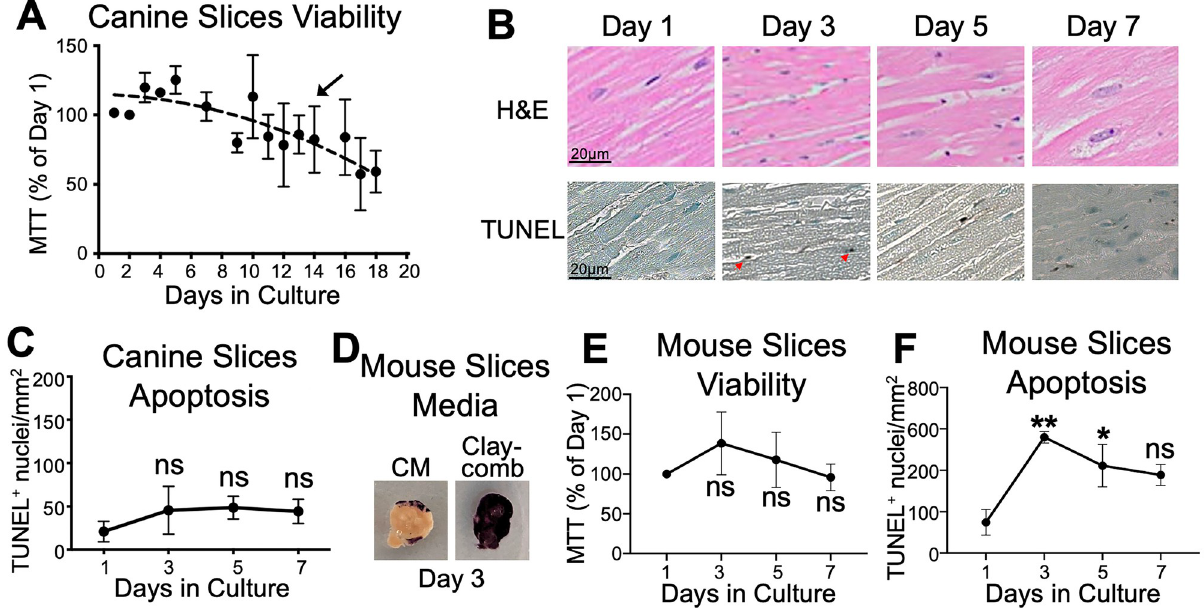
Fig 1. Canine cardiac slices are viable for > 7 days in culture. A. No significant reduction in adult canine cardiac slice viability through 14 days of culturing (arrow) by MTT staining was noted. N = 7 hearts. B. H&E staining demonstrated minimal myofibrillar damage during Day 1 (Billingham grade 0), 3 (Billingham grade 0), 5 (Billingham grade 1), and 7 (Billingham grade 1) of culture, and TUNEL staining showed minimal TUNEL + apoptotic cells. Red arrows: TUNEL+ nuclei. C. Quantification shows a low baseline of TUNEL+ nuclei which did not increase during 7 days in culture (n = 3 per condition). D. Adult mouse cardiac slices had much lower viability when cultured in the same canine media (CM) compared to the Claycomb media (MTT purple staining indicates viable tissue), E. in which tissues showed no significant decrease in viability within the 7 days of culture by MTT staining. F. However, TUNEL staining showed significant increase in apoptotic cells by day 3 of culture. N = 4, ANOVA with Dunnett’s post-test. � p < 0.05, �� p < 0.01, ns = no significant change.